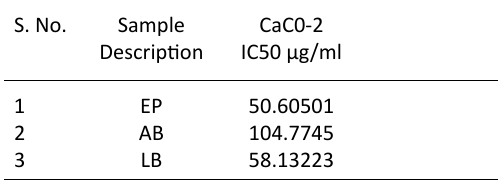
Table 2. Cytotoxicity studies